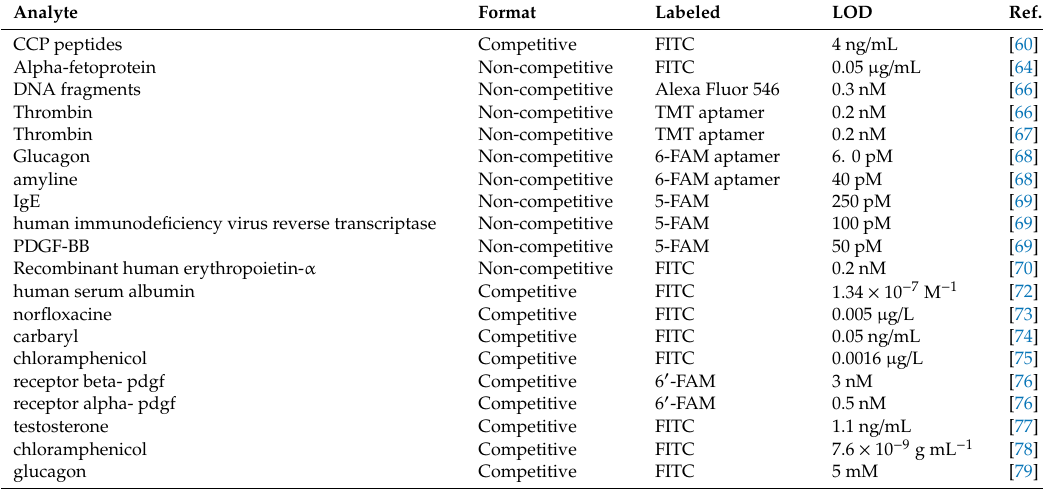
Table 1. Recent CE-LIF